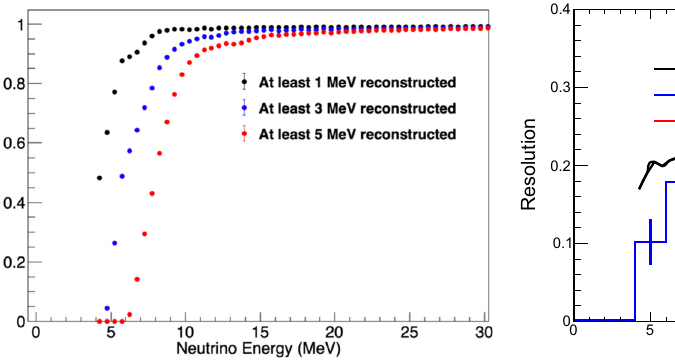
calorimetry (blue). The red “physics-limited resolution” is the ratio of the RMS to the mean of the deposited energy distribution, and assumes all energy deposited by final-state particles is reconstructed; the finite resolution represents loss of energy from escaping particles (primarily neutrons). Below 10 MeV the RMS of this distribution is